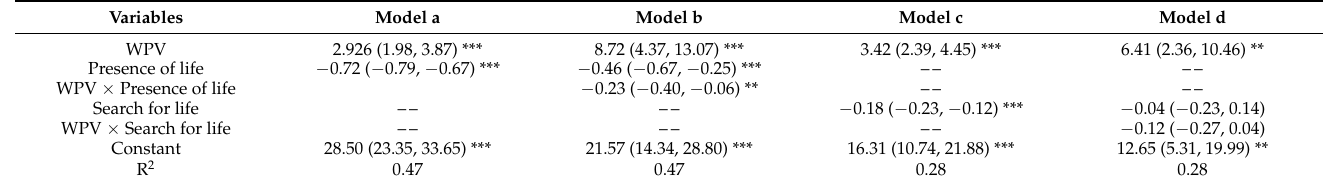
Table 3. Linear regressions for presence of life and search for life associated with depressive symptoms among primary healthcare professionals [ β (95% CI)].